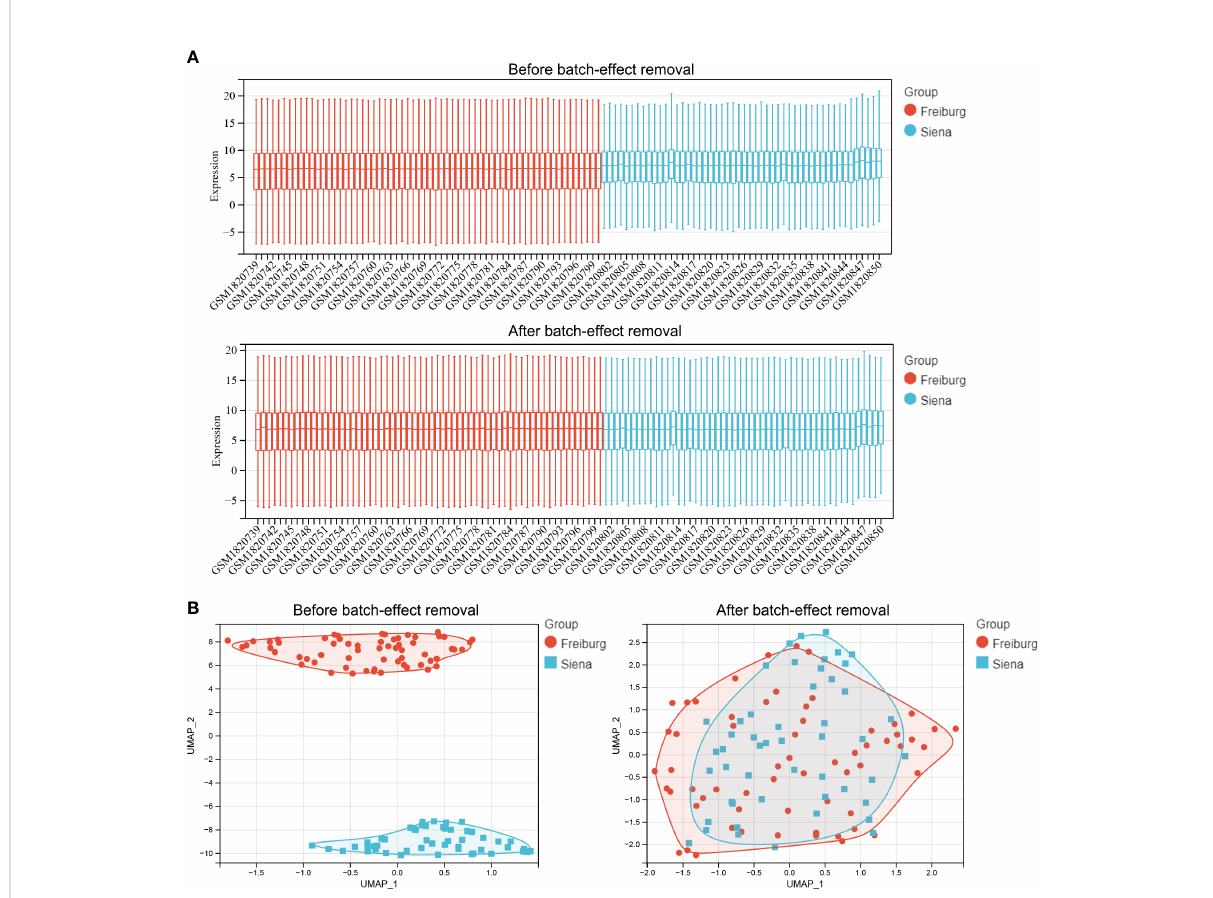
FIGURE 2 Comparison of expression data distribution and Uniform Manifold Approximation (UMAP) distribution before and after removal of the batch effect. (A) Expression data distribution. (B) UMAP distribution. The colors distinguish the Freiburg and Siena